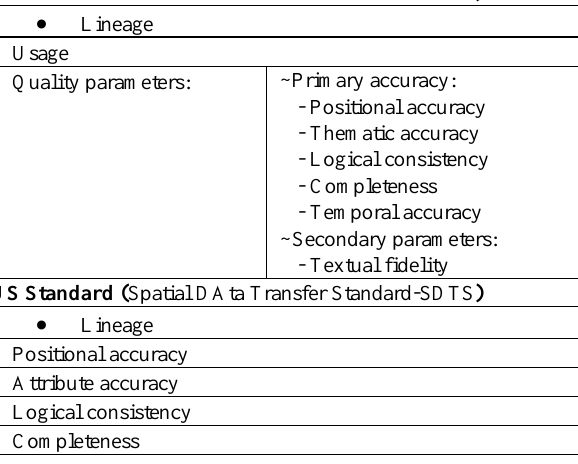
Table 1. Set of European and US Standards for analysis of